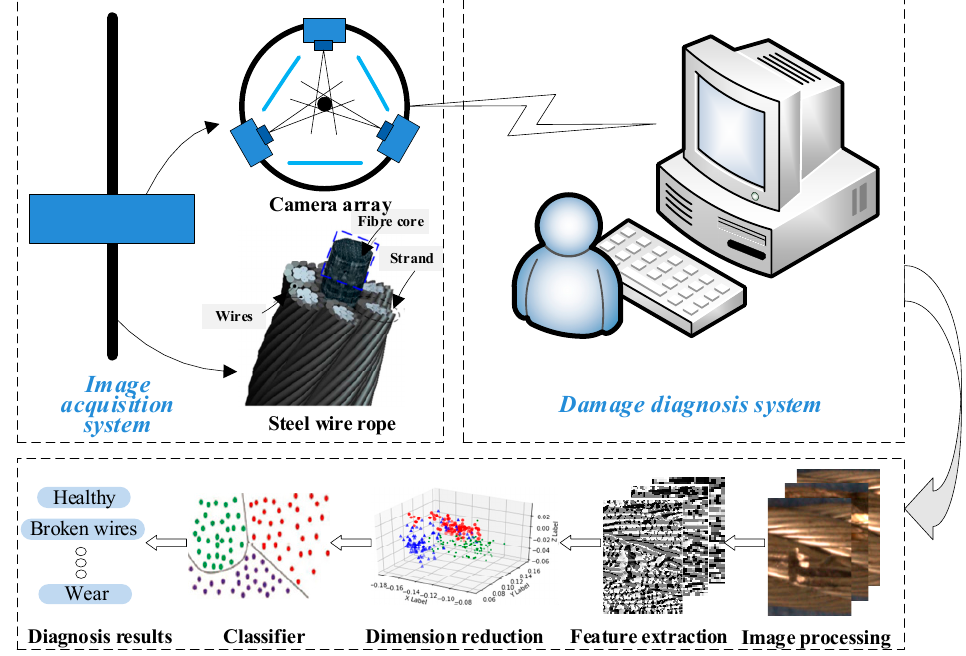
Figure 3. Optical detection principle for steel wire rope.